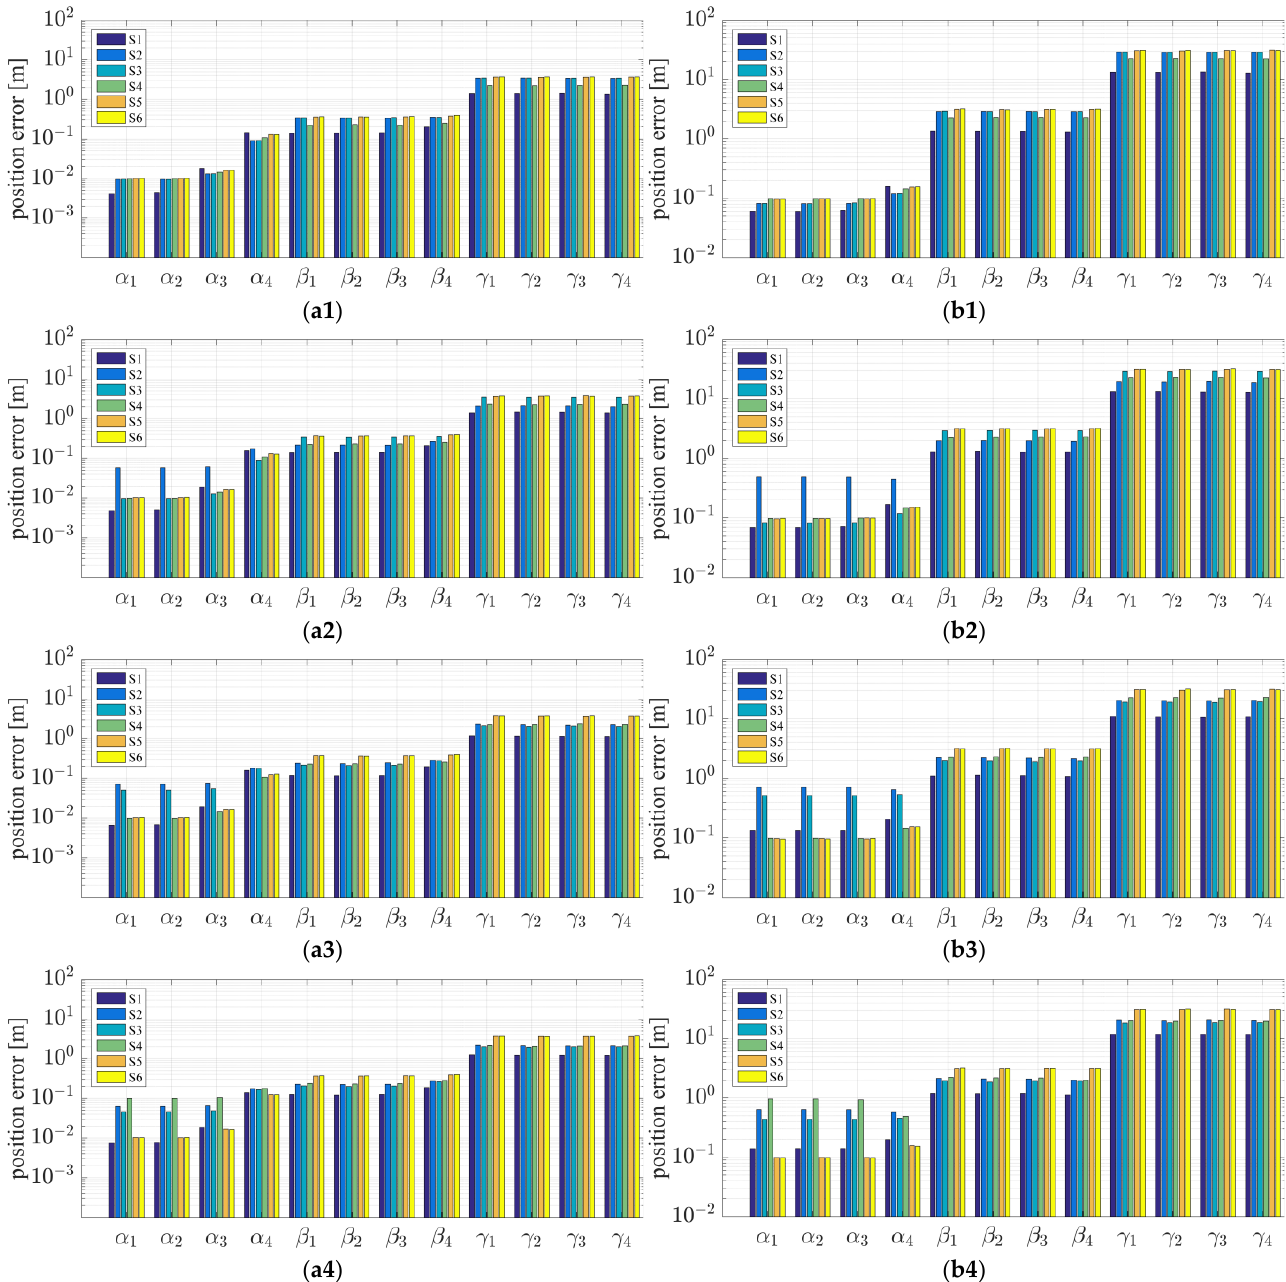
Figure 18. Statistics on the relative navigation accuracy under different simulation scenarios: ( a1 ) Case a: space-circle radius 1 km and 6 chief satellites; ( b1 ) Case a: space-circle radius 10 km and 6 chief satellites; ( a2 ) Case b: space-circle radius 1 km and 5 chief satellites; ( b2 ) Case b: space-circle radius 10 km and 5 chief satellites; ( a3 ) Case c: space-circle radius 1 km and 4 chief satellites; ( b3 ) Case c: space-circle radius 10 km and 4 chief satellites; ( a4 ) Case d: space-circle radius 1 km and 3 chief satellites; ( b4 ) Case d: space-circle radius 10 km and 3 chief satellites.